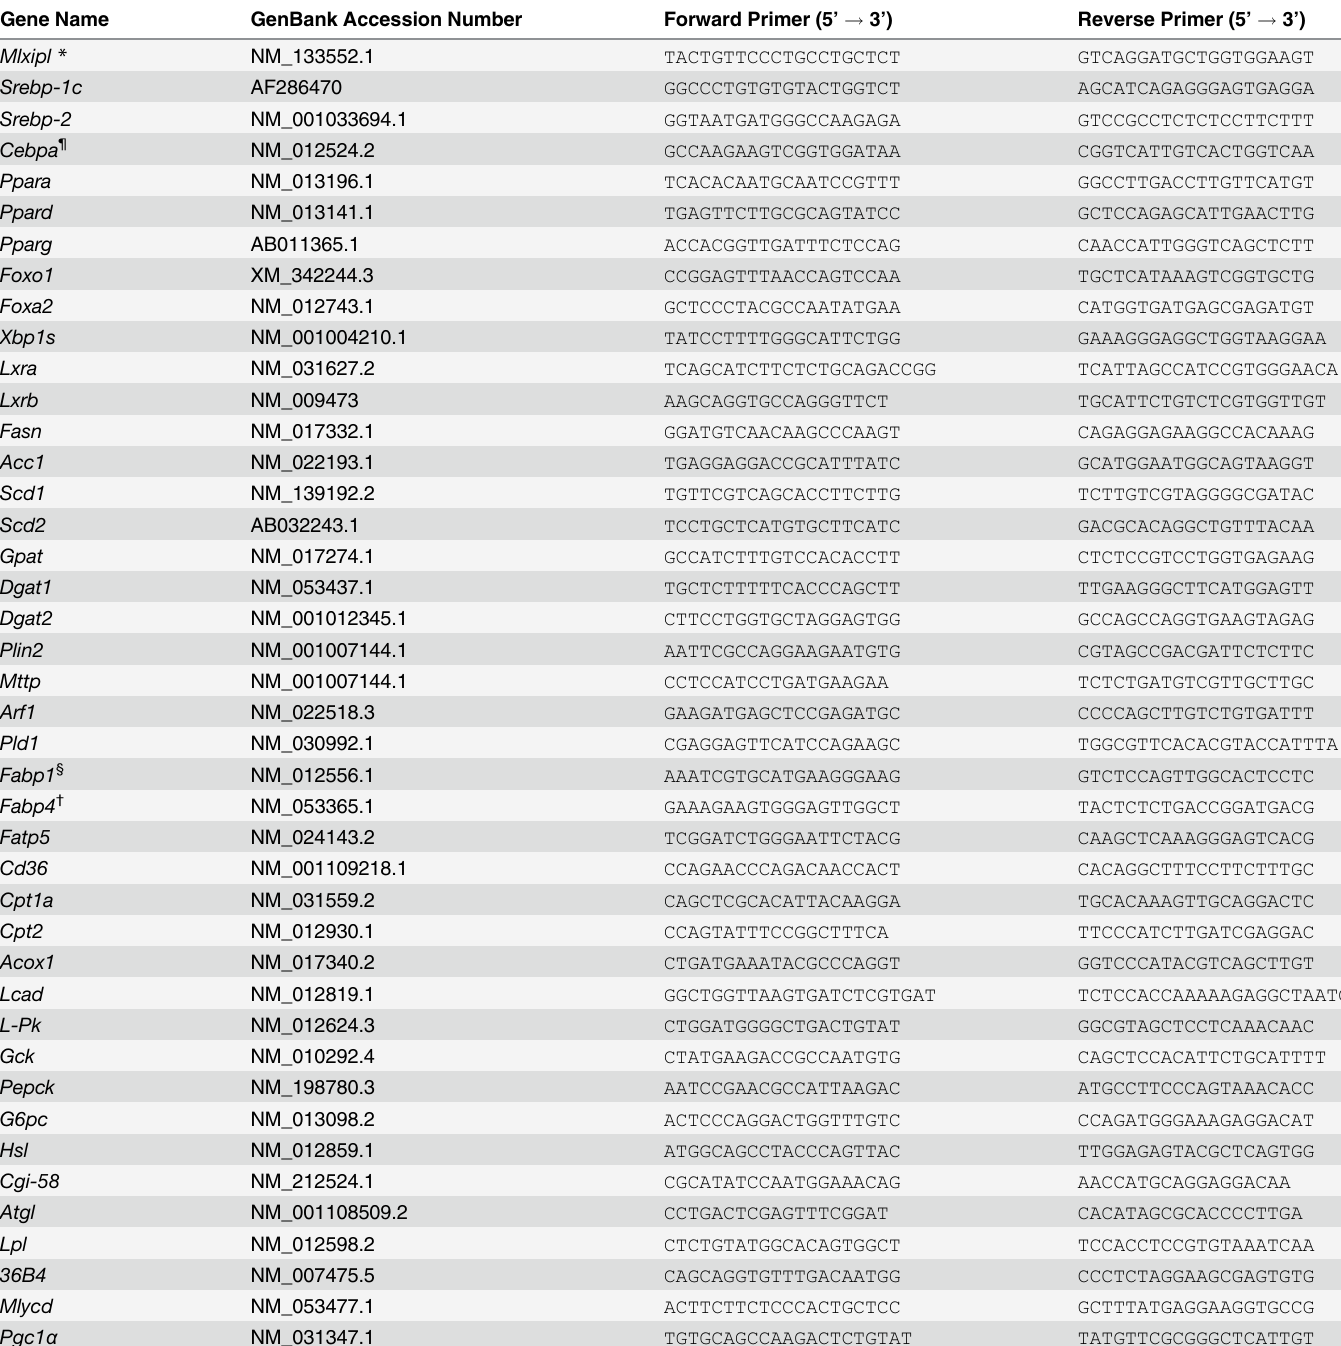
Table 1. Primers used in quantitative real-time RT-PCR for detecting gene expression in rat liver